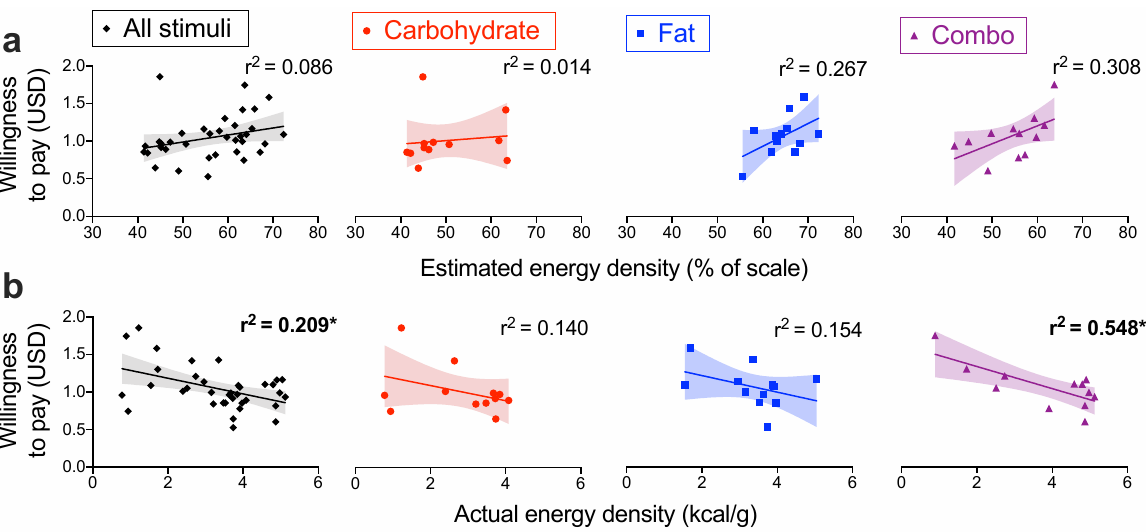
Figure 3. WTP is negatively associated with actual, but not estimated, energy density across all stimuli and in combo foods. Fitted scatter plots depict the relationships of WTP with ( a ) estimated energy density and ( b ) actual energy density. Resulting r 2 values are shown for each regression performed on all food items (averaged across all participants) or broken down by the carbohydrate, fat, and combo categories. Each data point depicts a single item (36 total stimuli or 12 foods per macronutrient category) and shading indicates 95% CI. * p < 0.0063 after Bonferroni correction for the eight